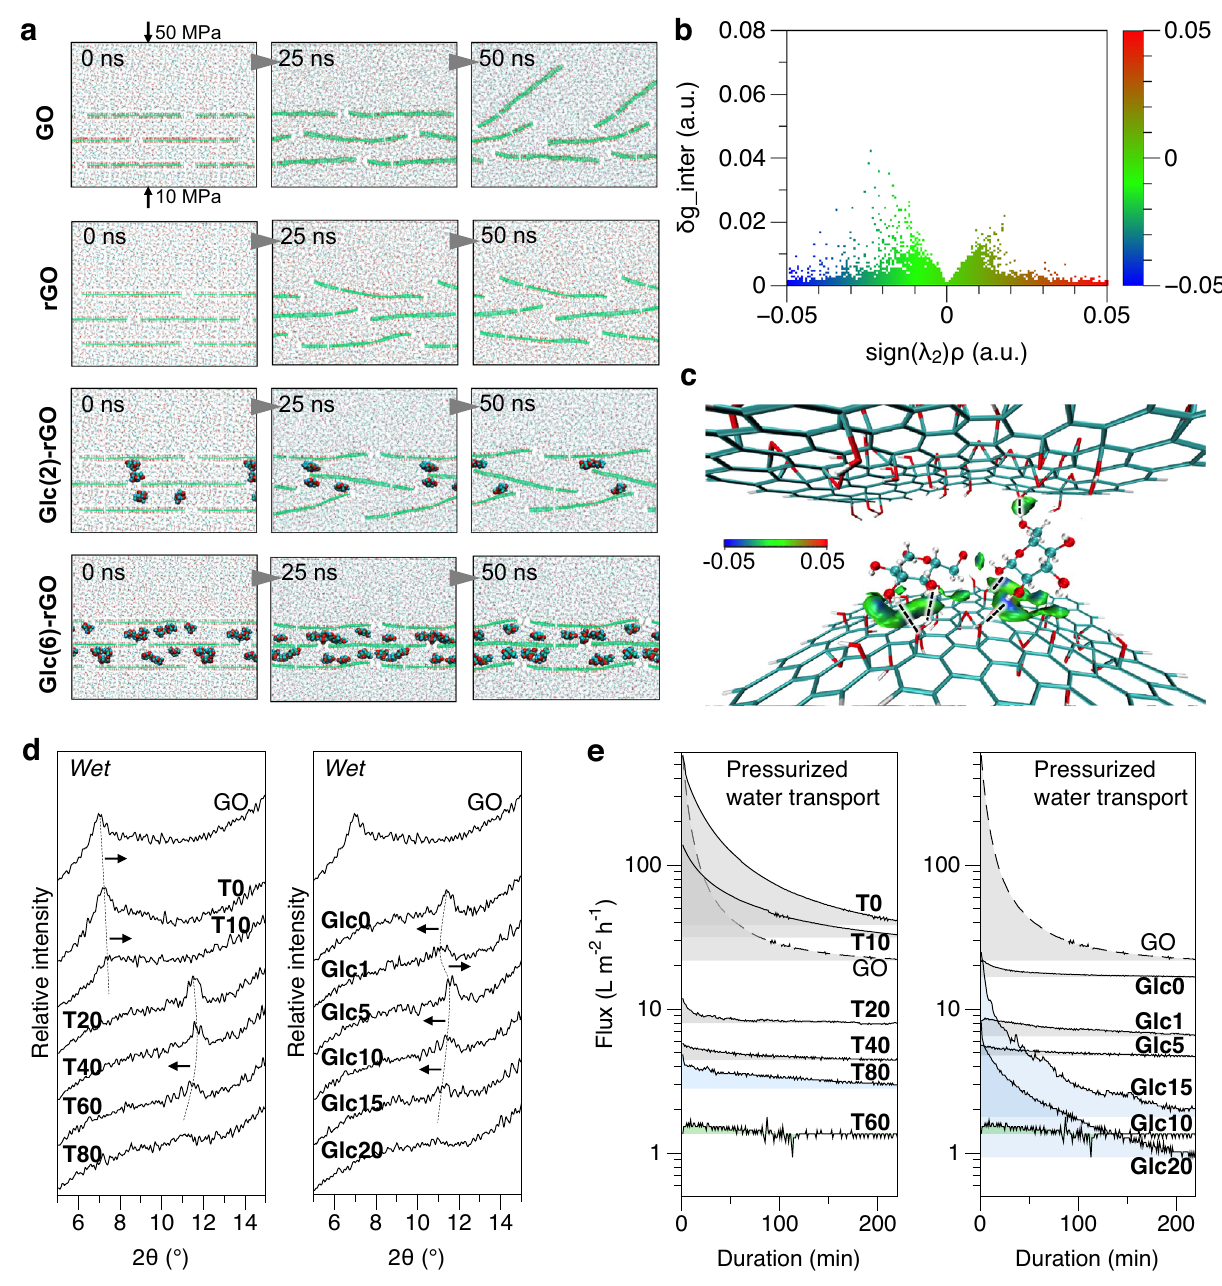
λ δ g_interwithanisovalueof 2 oftheelectrondensityHessianmatrix; c Isosurfaceof 0.005 a.u. The blue isosurface between the oxygen-containing group of rGO and the hydroxyl group of Glc indicates the C-H … O hydrogen bond interactions as depicted by dashed lines; d XRD spectra of wetted GO and Glc-rGO samples (dashedlinesandarrowsindicatepeakshifts); e Time-coursepurewater fl uxofGO andGlc-rGOsamplesat1MPa.GlcratioforGlc-rGOsamplesderivedfromdifferent reaction periods (T0 – T80)was fi xed at 10(Glc10), whereas the reaction periodfor Glc-rGOsamplesderivedfromdifferentGlcratios(Glc0 – Glc20)was fi xedat60min (T60). Source data are provided as a Source Data fi